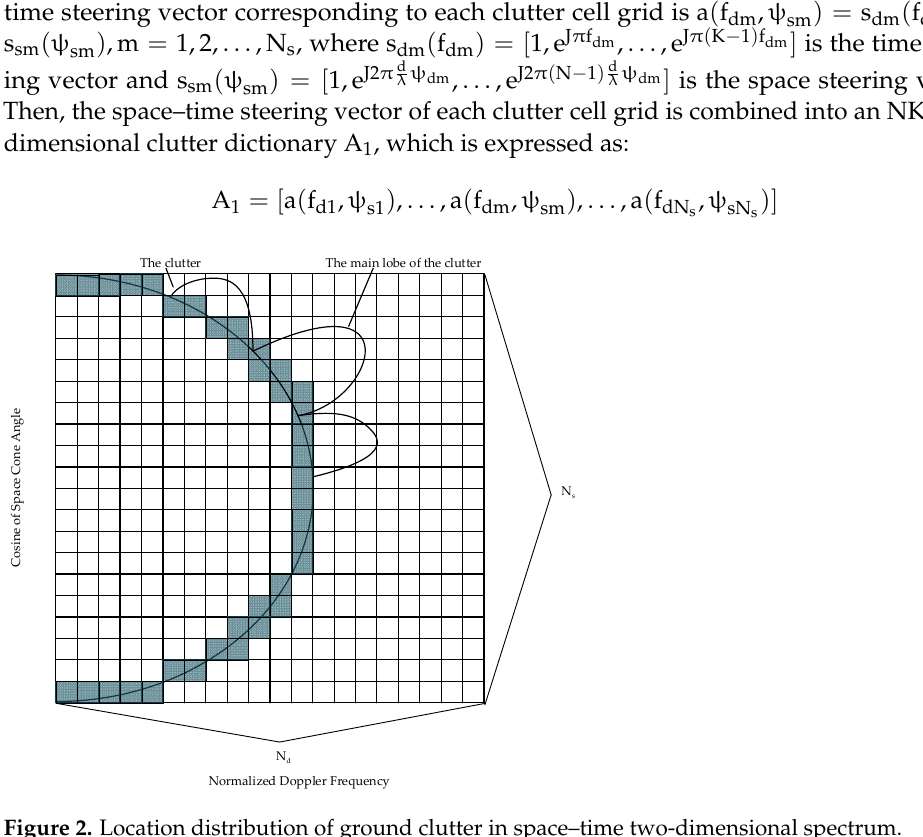
Figure 2. Location distribution of ground clutter in space–time two-dimensional spectrum.